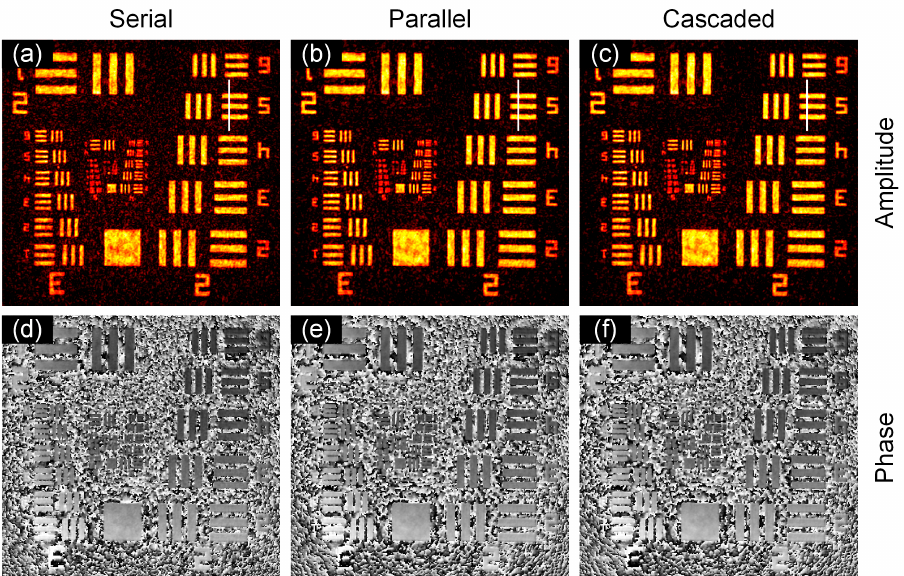
Figure 8. The experimental results. ( a – c ) Recovered amplitudes of the three methods; ( d – f ) reconstructed phases of the three methods.